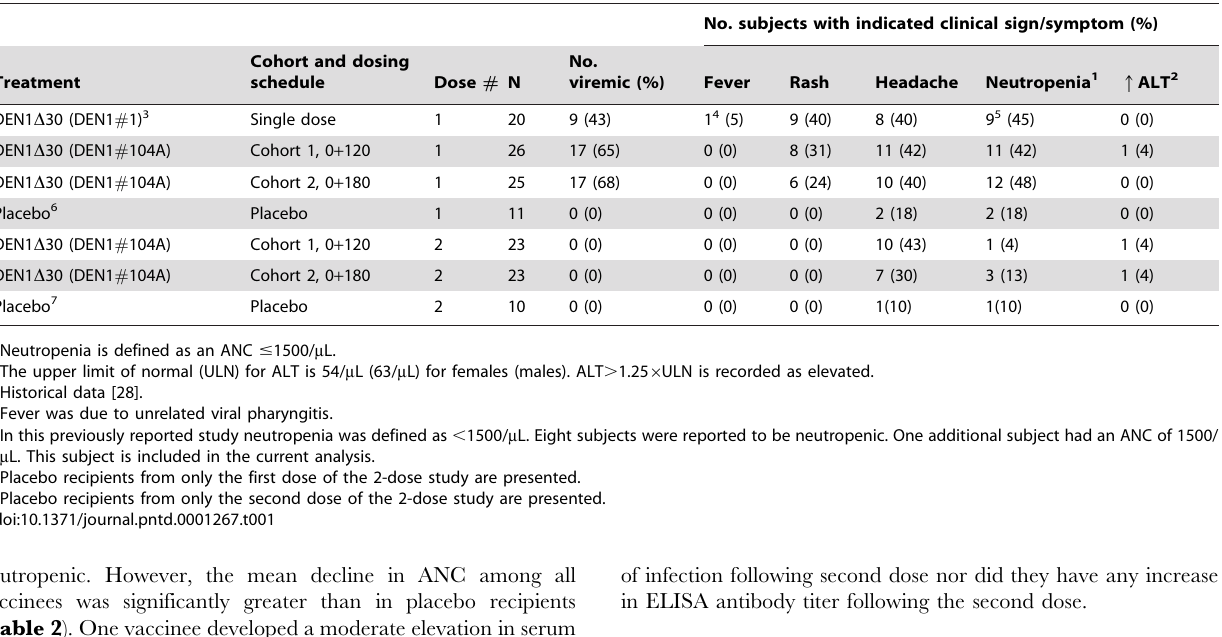
Table 1. Clinical and virology data from subjects vaccinated with rDEN1 D 30 or placebo.